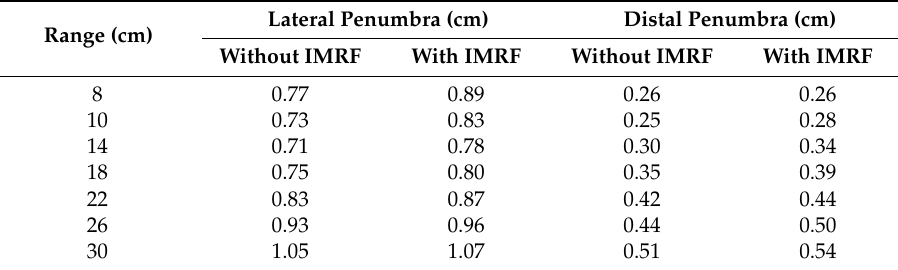
Table 2. Lateral and distal penumbras for the phantom. The spread-out Bragg peak width is 4 cm for all